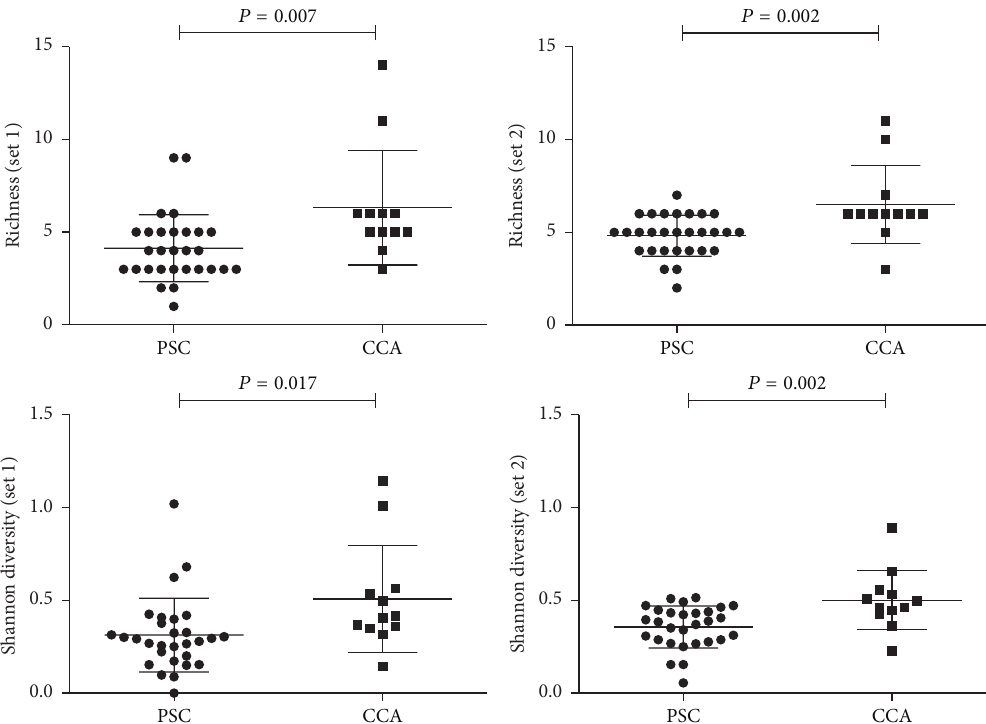
Figure 3: Genetic clonal diversity in primary sclerosing cholangitis and cholangiocarcinoma. 𝑃 values are compared with use of Student’s 𝑡